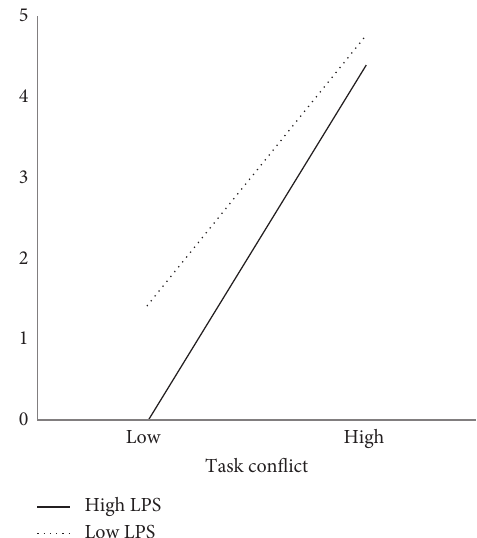
Figure 2: Moderating Effects of Team Leadership Political Skills on Task Conflict and Performance.